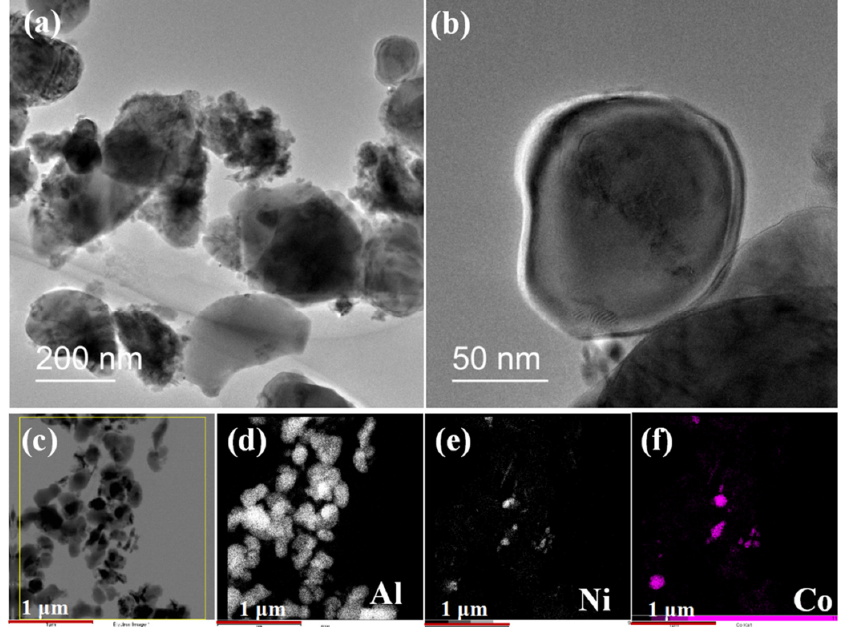
Figure 3. TEM images ( a,b ), STEM image ( c ), EDX mapping of the NiCo/ α –Al 2 O 3 catalyst ( d – f ).